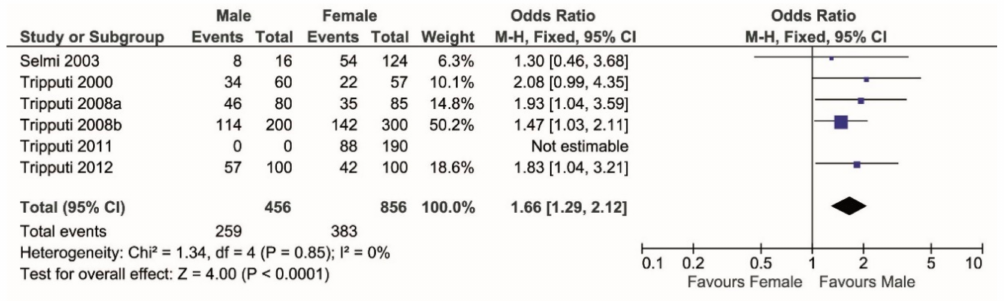
Figure 2. Forest plot comparing the percentage of T/C genotype (events) over the TC + TT + CC (total) in males versus females. T/C shows higher frequency in females.